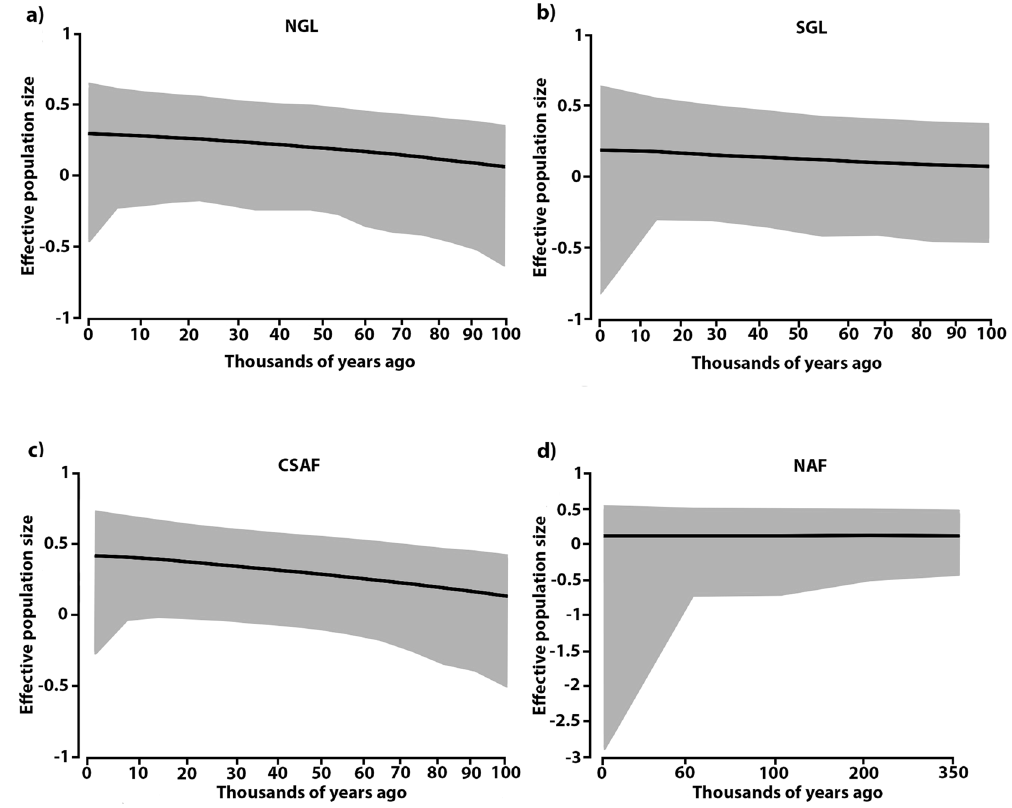
Figure 3. Comparison of demographic size through time. Extended Bayesian skyline plot (EBSP) using combined mtDNA and nDNA data sets of the major haplogroups of S. cyanea ( a) and ( b ) and S . aff. septentrionalis ( c ) and ( d ). The EBSP shows median effective population sizes (black line) over the past and the shaded indicating the 95% HPD. The population size axis is on a logarithmic